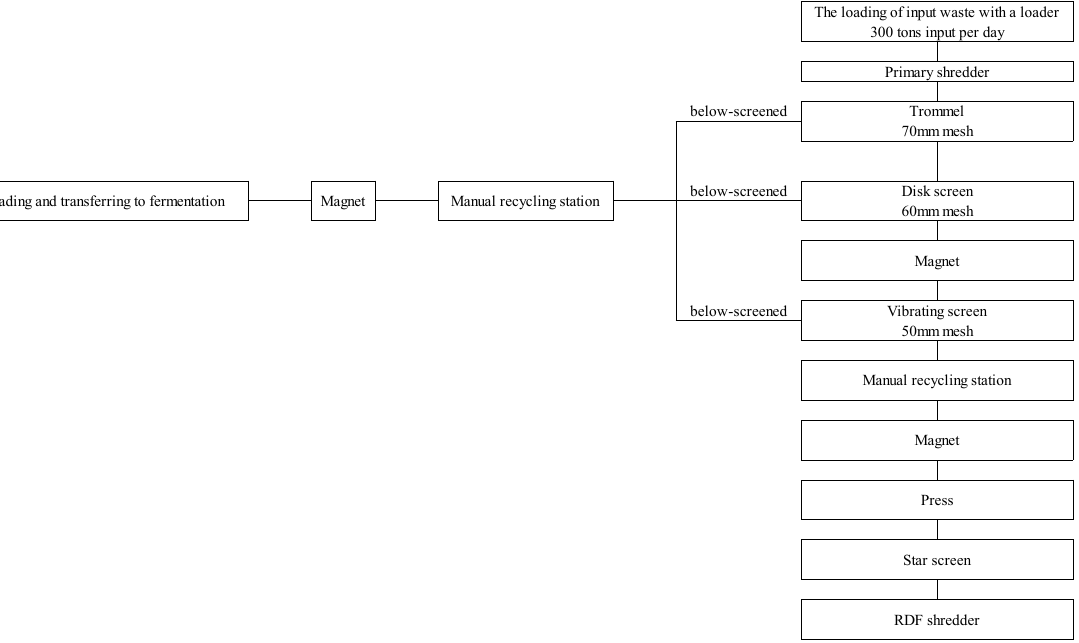
Figure 2 . The diagram of MBWT process of Babol city's waste up to RDF production